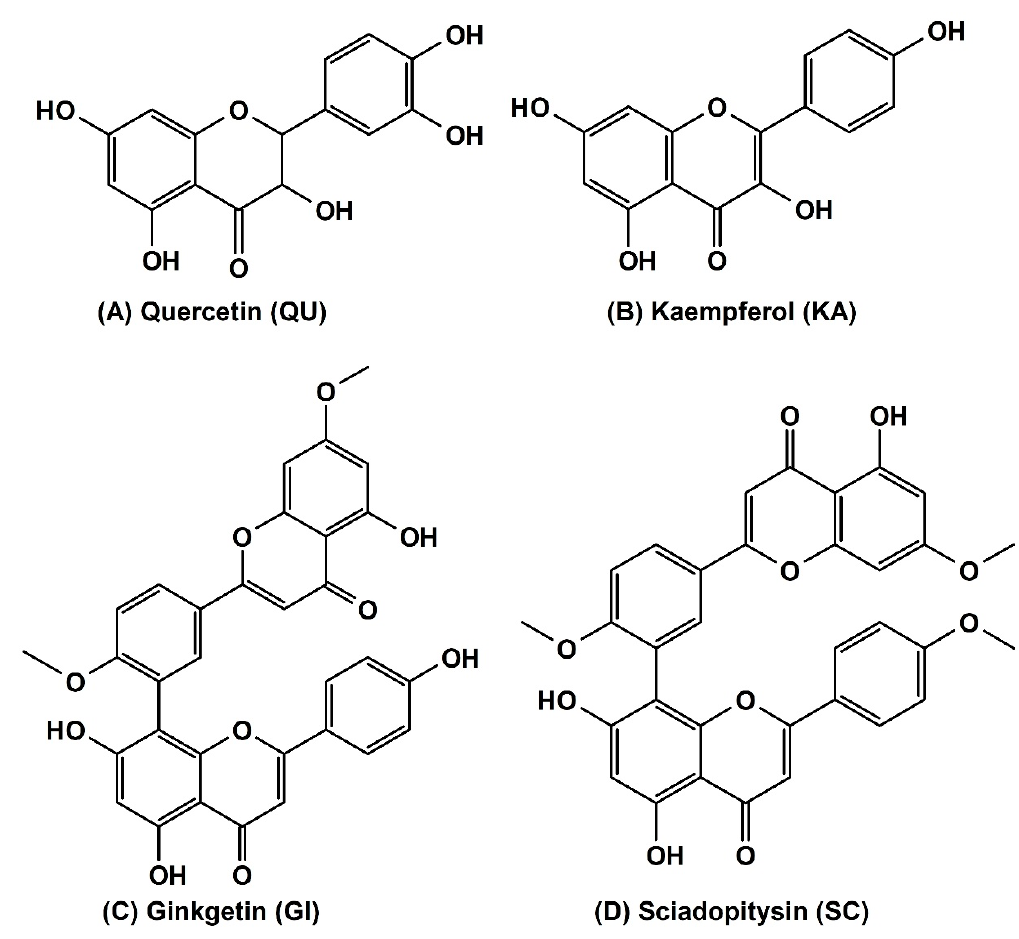
Figure 1. The chemical structures of quercetin (QU), kaempferol (KA), ginkgetin (GI) and sciadopitysin (SC).